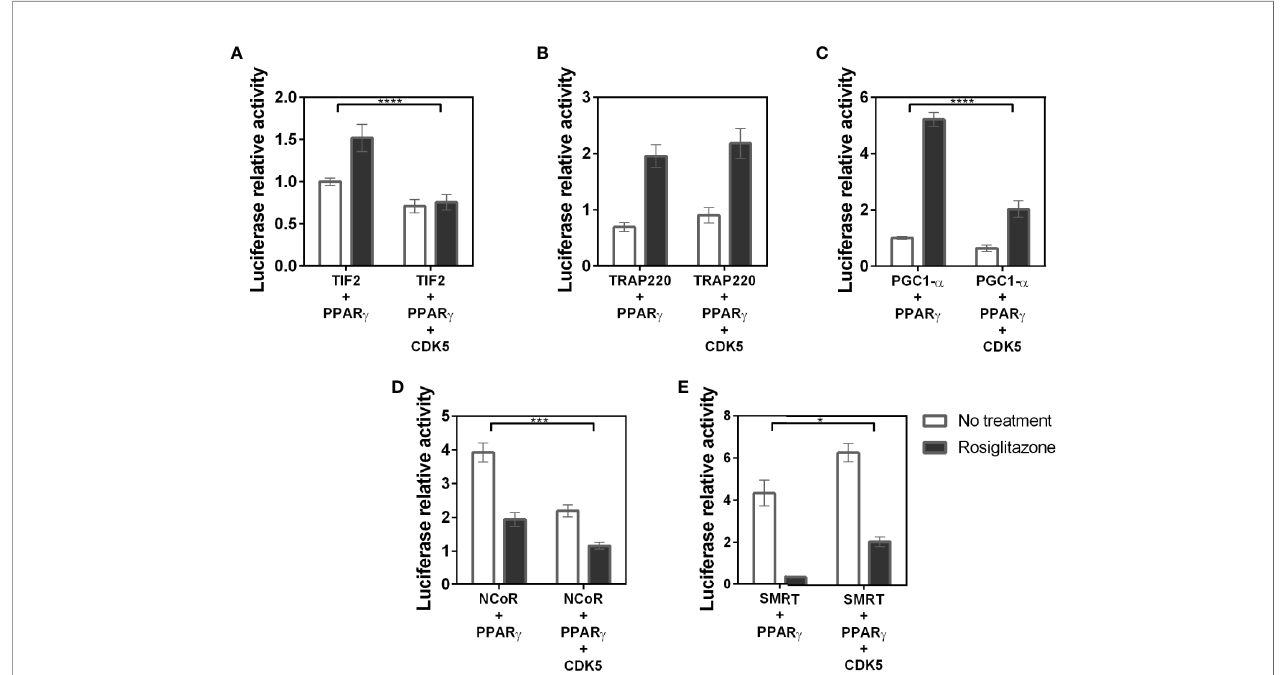
FIGURE 8 | Interaction between coregulators and the PPAR g receptor in the presence of the CDK5 enzyme. Mammalian two hybrid assays to evaluate if the presence of the CDK5 enzyme, responsible for the phosphorylation of S273 in the receptor, interferes with PPAR g :coregulators interaction. (A) Interaction of the TIF 2 coactivator with PPAR g in the absence and presence of CDK5. (B) Interaction of the TRAP220 coactivator with PPAR g in the absence and presence of CDK5. (C) Interaction of the PGC1- a coactivator with PPAR g in the absence and presence of CDK5. (D) Interaction of the NCoR corepressor with PPAR g in the absence and presence of CDK5. (E) Interaction of the SMRT corepressor with PPAR g in the absence and presence of CDK5. Error bars, SEM. (n = 15) Statistical analysis: two-way ANOVA. P values: p ≤ 0.05*; p ≤ 0.001***; p ≤ 0.0001****. PGC1- a , TIF2 and NCoR showed dissociation of the receptor in the presence of CDK5 while SMRT increased the association with the